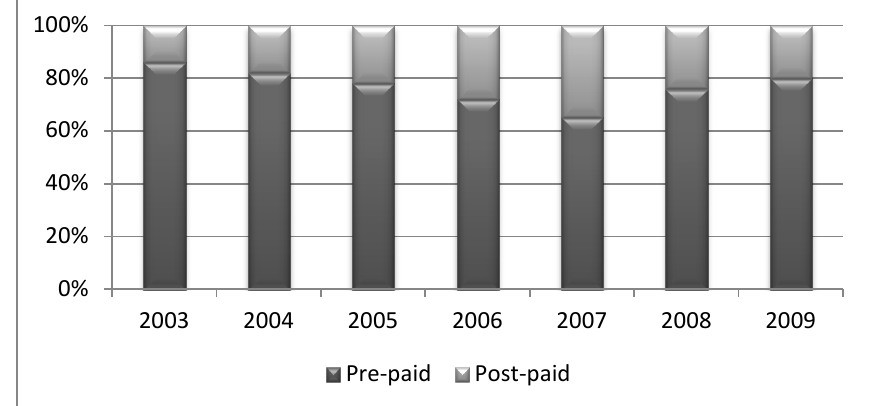
FIGURE 1: Cell C customer base: prepaid and contract contributions (percentage) Source: Cell C (2010)